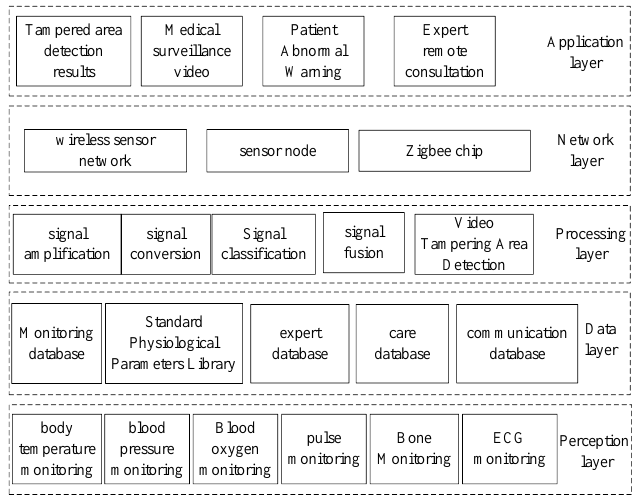
Figure 1. Overall structure of the